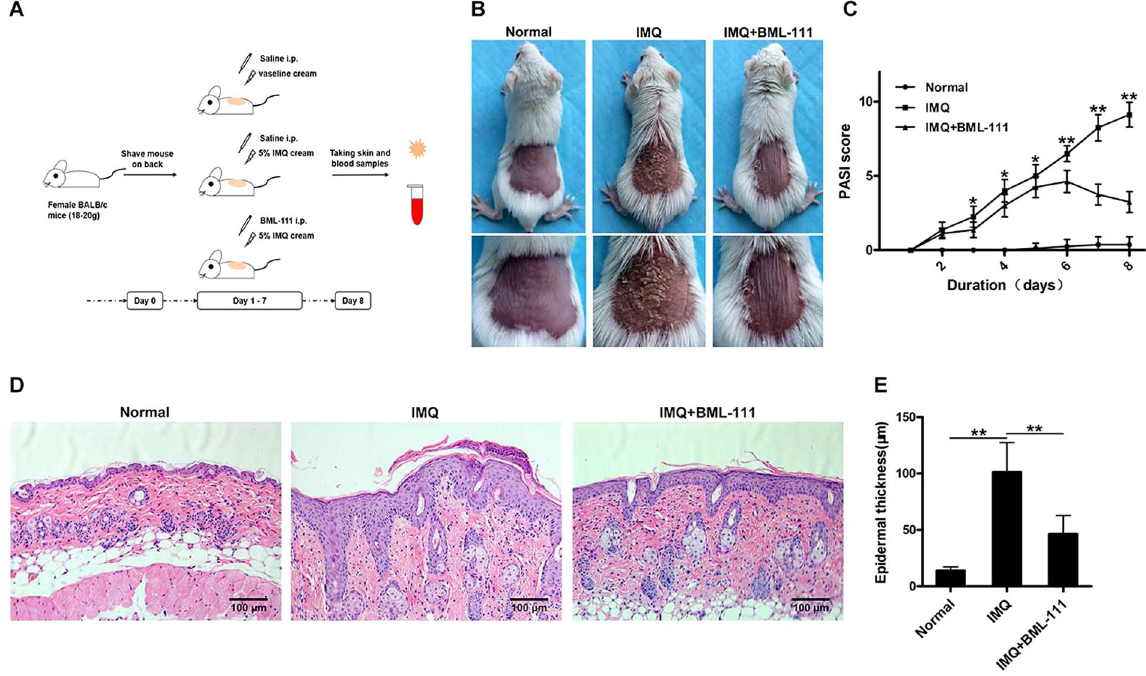
Figure 1. BML-111 improves the morphological and histological features of IMQ-induced psoriasiform dermatitis in mice. ( A ) Schematic representation of the animal experiment protocol. ( B ) Representative macroscopic views of the dorsal skin of BALB/c mice following continuous treatment for 8 days. ( C ) Epidermal erythema, scaling and thickening of the dorsal skin were evaluated daily; the clinical PASI score was calculated by adding the scores of the three separate criteria (range from 0 to 12). ( D ) HE staining of cross-sectional slices from the dorsal skin of the three groups of mice. ( E ) Epidermal thickness of the dorsal skin on day 8. ** p < 0.01 and * p < 0 . 05 , compared with the mice in the IMQ group. Each bar represents the mean ± SD (n =